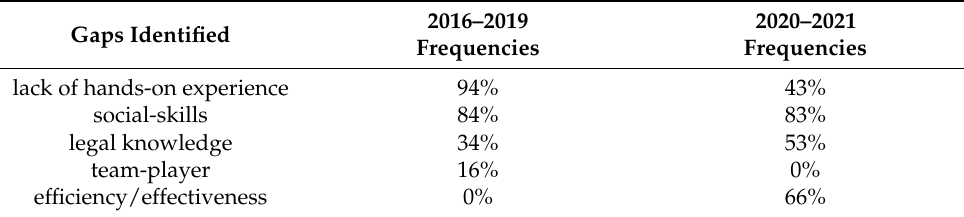
Table 5. Gaps between academic knowledge and internship experience. Gaps